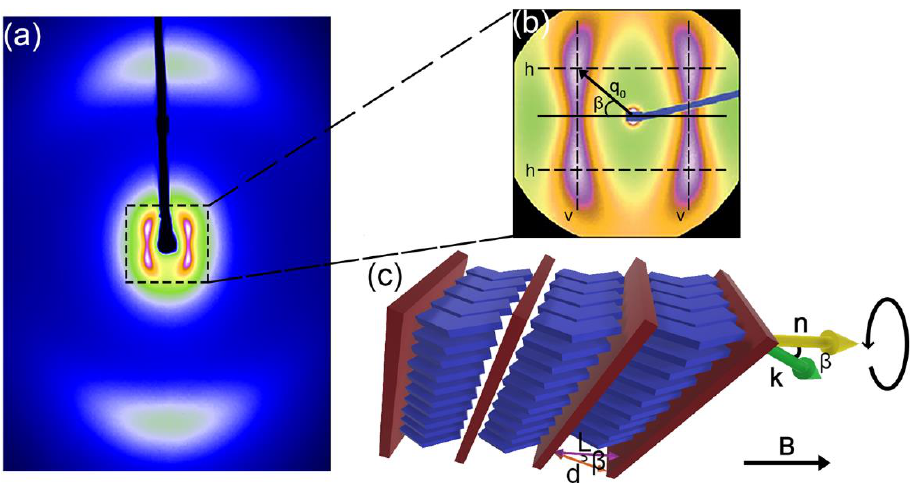
Figure 2. ( a ) Representative wide-angle XRD pattern of BCM skewed cybotactic nematic phase, here measured for compound 1a aligned by a horizontal magnetic field. ( b ) Low-angle XRD pattern of the same sample, measured at the same conditions of temperature and magnetic field. ( c ) Schematic diagram of a skewed cybotactic group (symbols are defined in the text). The layer normal k of each cluster is randomly oriented around the nematic director n (aligned by the magnetic field B ) and forms with it an angle β .